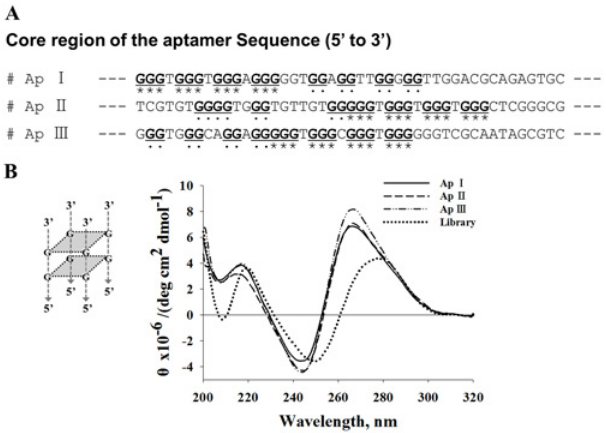
Fig 6. G-rich sequence of the core region and CD spectra of selected ssDNA aptamers. (A) G-rich sequences participating in the formation of G-quadruplex structures as predicted by QGRS Mapper in bold type and underlined. (B) CD spectra as collected on a Chirascan-plus CD spectrometer at 200 – 320 nm.